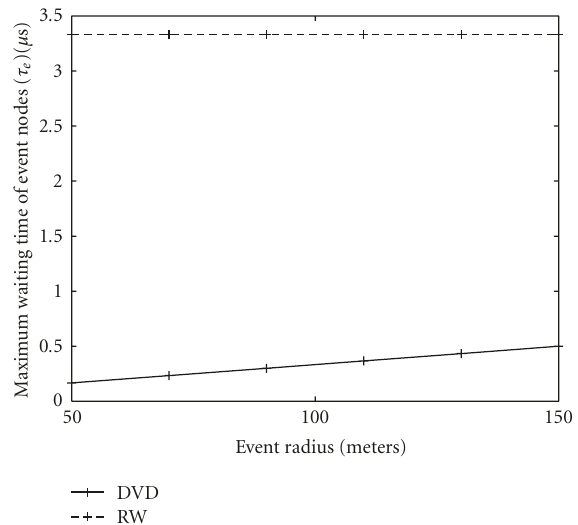
Figure 17: Upper bound on waiting time of event nodes τ e with event radius in DVD and RW.